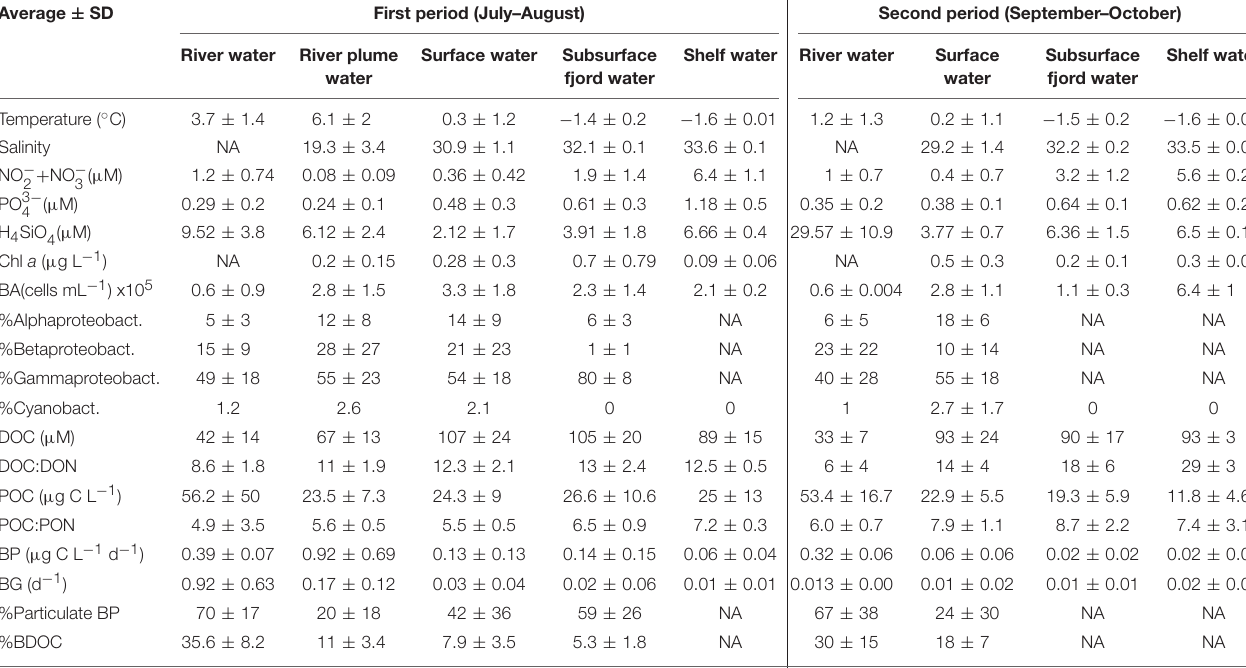
TABLE 3 | Water type characteristics and properties shown as average ± SD of the 5 water types for each of the two